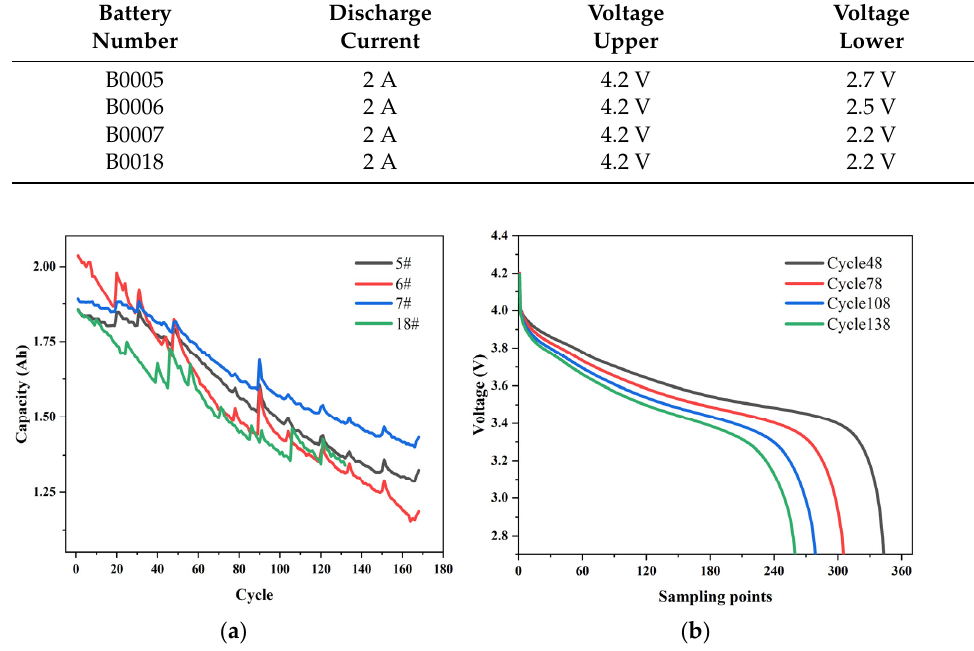
Figure 2. Battery aging process and discharge voltage variation: ( a ) capacity attenuation curve; ( b ) voltage variation of the aging cycle schemes follow another format. Table 1. Experiment condition of the battery.